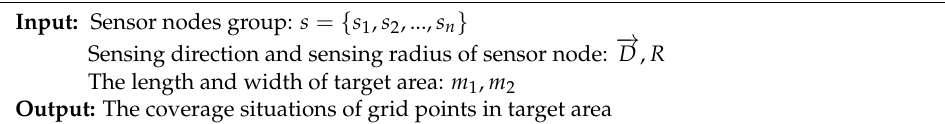
Algorithm 1: Coverage verification algorithm based on the sensing area of sensor